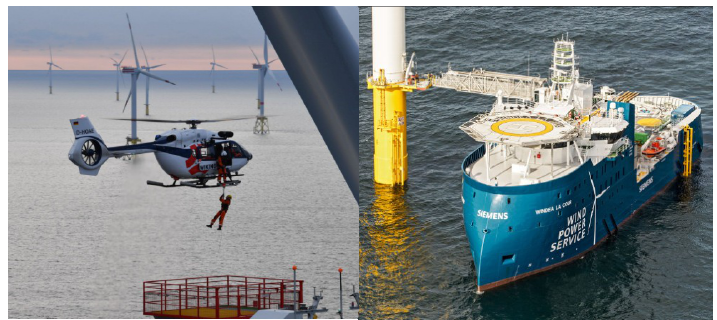
Figure 19. Transportation for the operation and maintenance of smart offshore wind